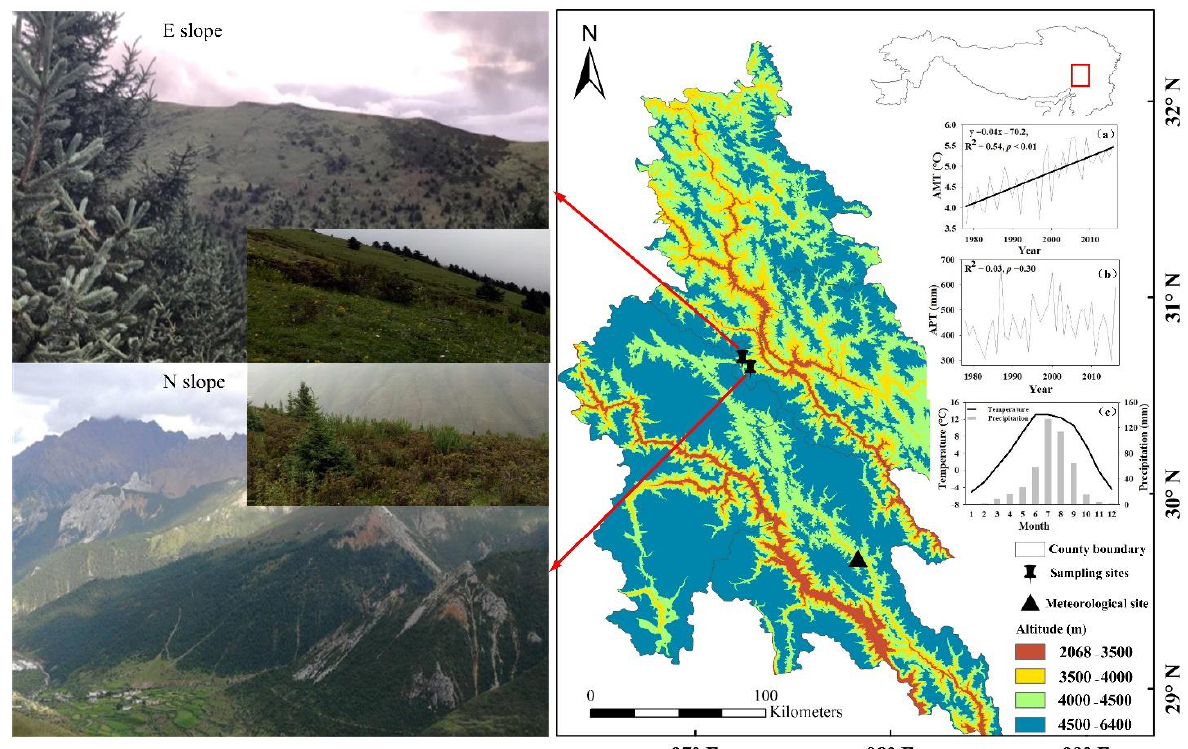
Figure 1. Study area and the annual mean temperature ( a ), annual precipitation ( b ), and monthly mean temperature and total precipitation ( c ) at the nearest meteorological station in Zuogong County. The R 2 and p values of fitted curves are given.